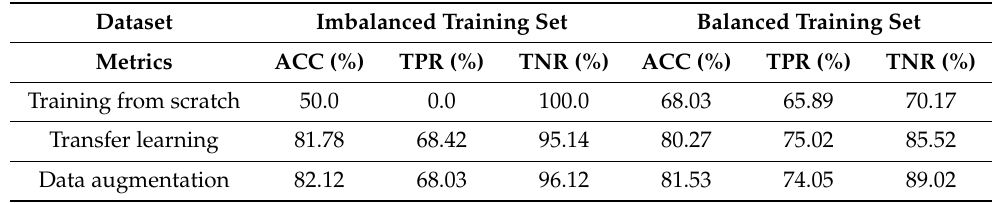
Table 3. Experimental results of the